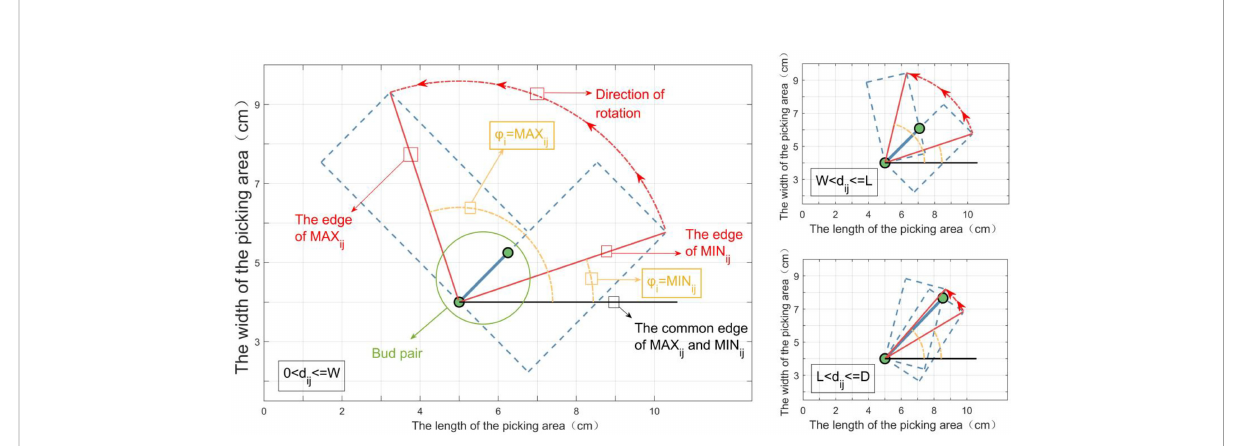
FIGURE 6 The minimum/maximum angles formed by the rotating action of box i. .